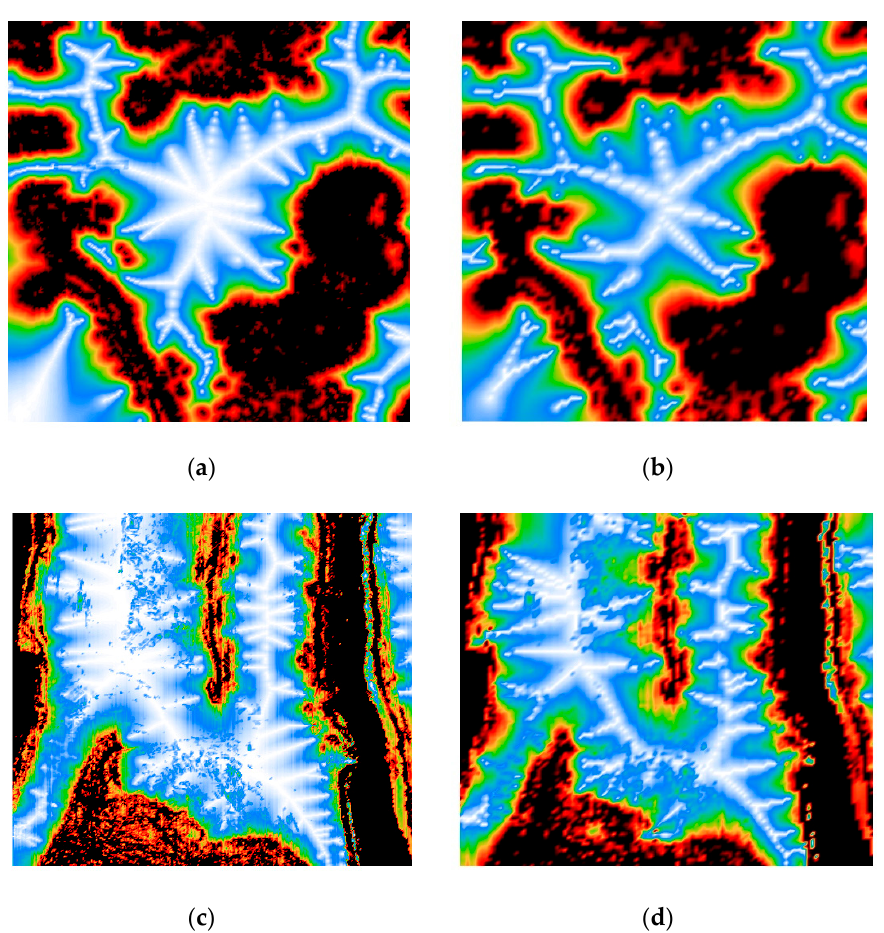
Figure 16. Two scenes with different terrain resolution. ( a , c ) are the 0.5 m terrain resolution scenes; ( b , d ) are the 1.0 m terrain resolution scenes.